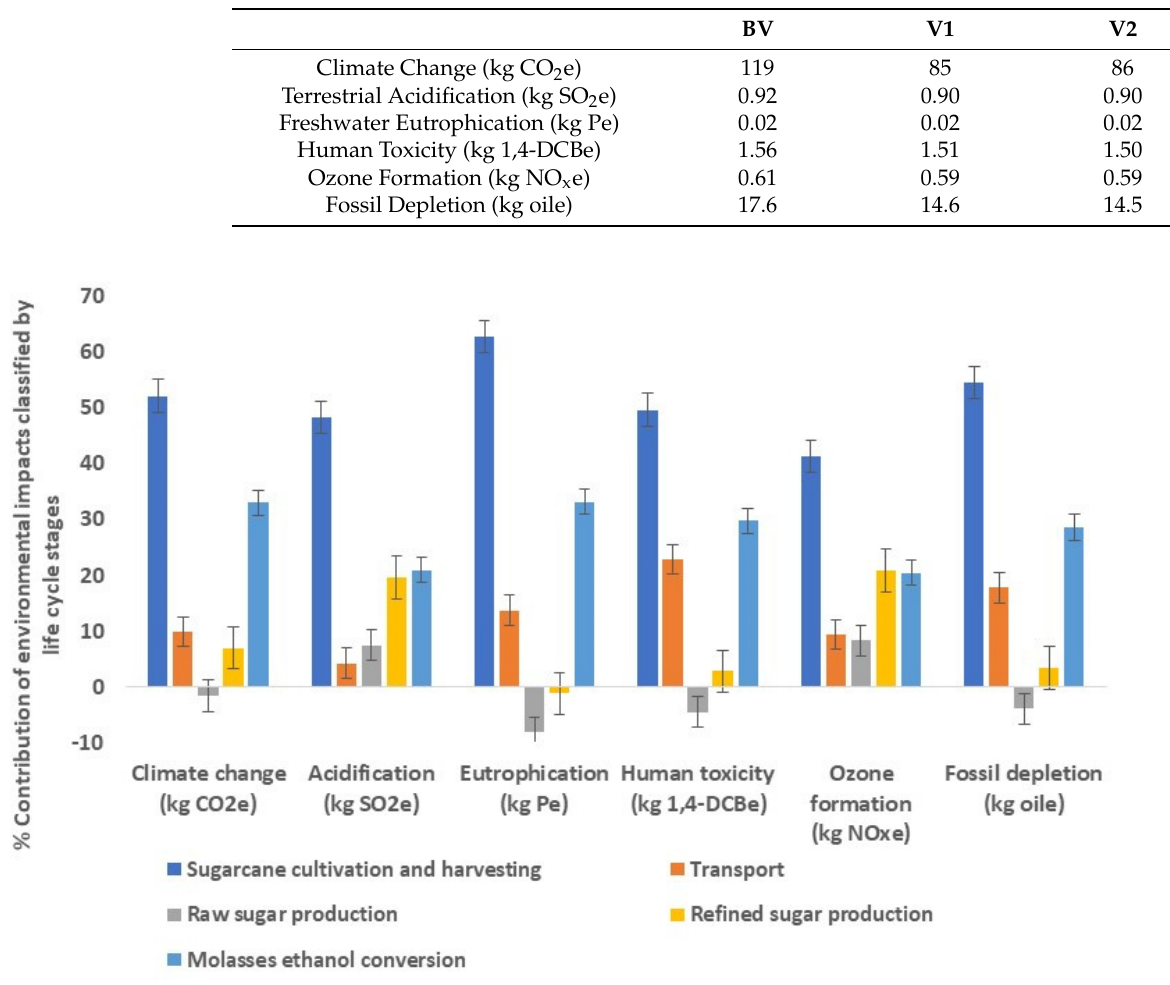
Table 6. Environmental impact potentials per tonne of cane processed for different vinasse utilization scenarios.